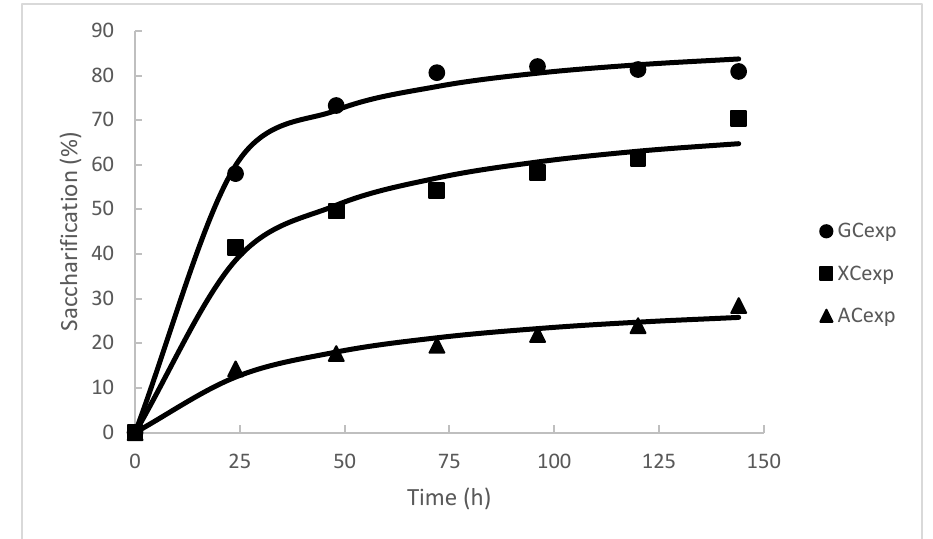
Figure 3. Modelling of enzymatic hydrolysis by extract MD. GCexp: glucan experimental conversion; XCexp: xylan experimental conversion; ACexp: Arabinose experimental conversion. The release of glucose (R 2 : 0.9993), xylose (R 2 : 0.9969), and arabinose (R 2 : 0.9943)